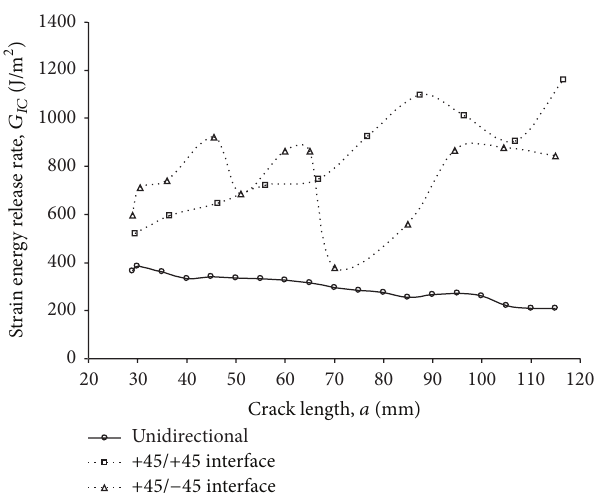
Figure 19: Comparison of R-curves [27] of DCB specimens with different stacking sequence made of carbon/epoxy (XAS-913C, Ciba Geigy